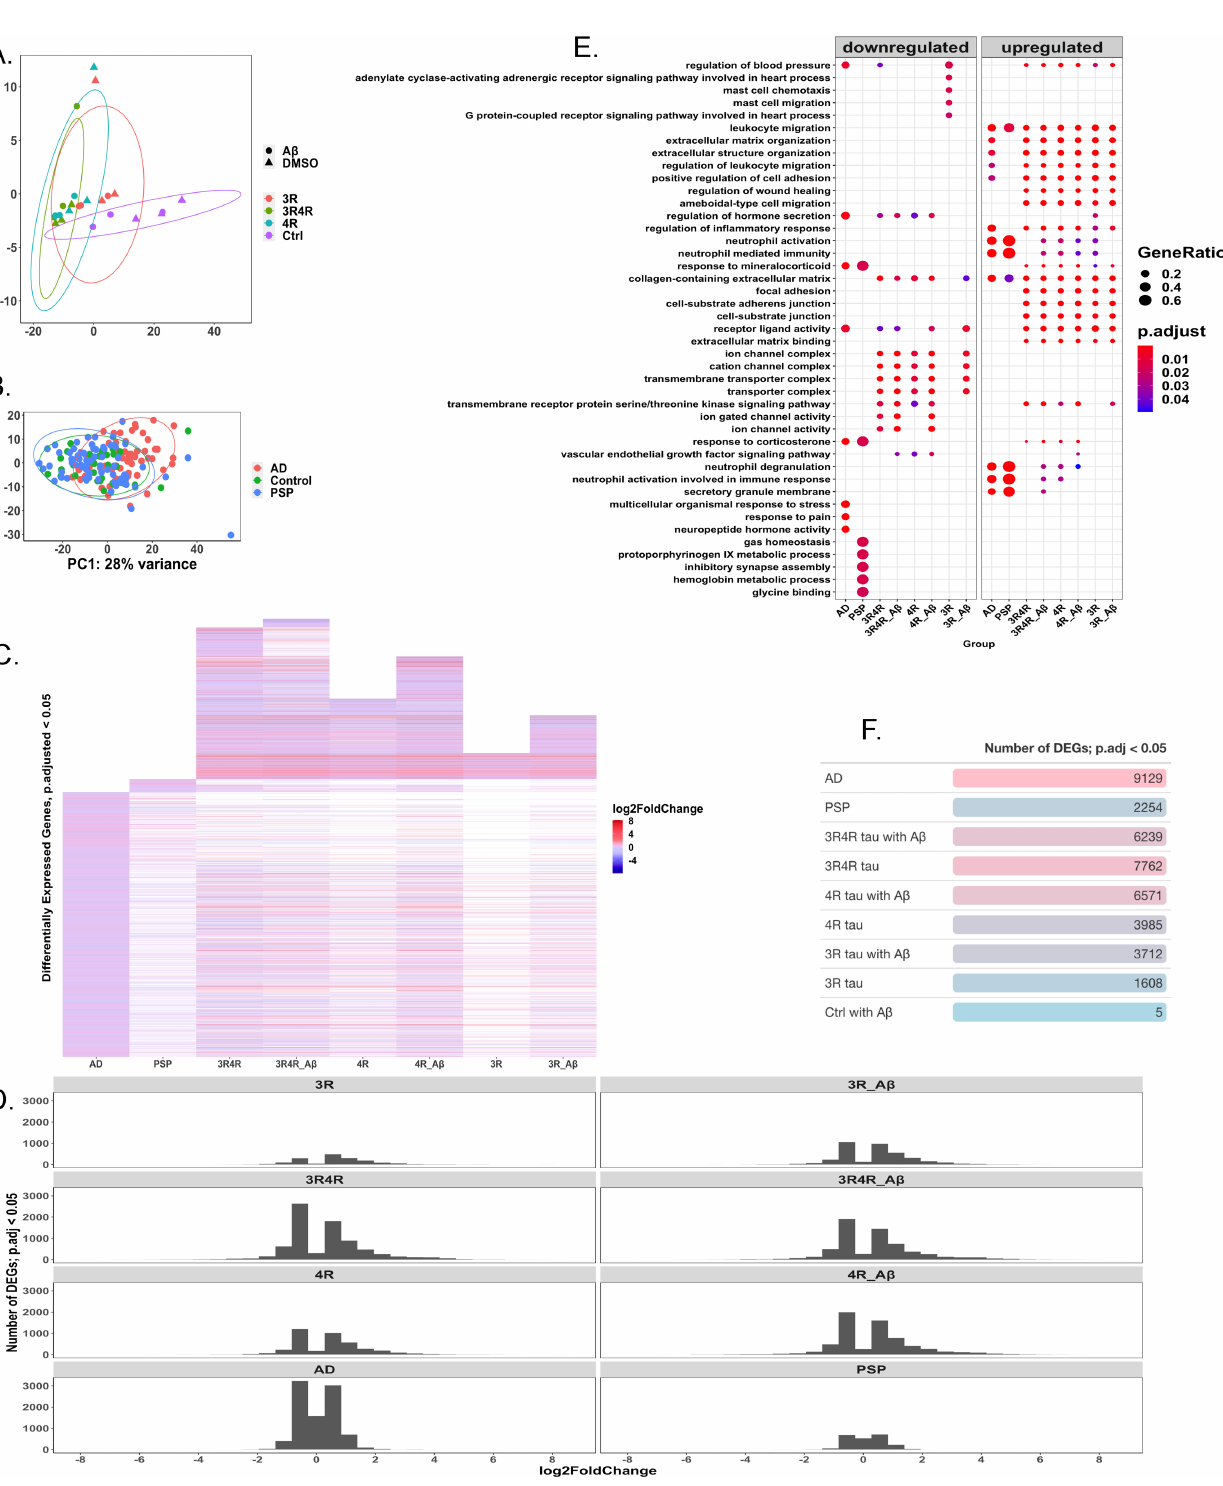
Fig 4. Patterns in differentially expressed genes in AD, PSP, and cell models. (A) PCA displaying grouping by gene expression between lentivirus and treatment conditions; PC1 accounts for 81% of variance between conditions and there is little separation between A β and DMSO-treated groups (N = 3). (B) PCA displaying grouping by gene expression between AD (N = 60), control (N = 33), and PSP (N = 71) patients. PC1 accounts for 28% of variation, with AD patients showing greater separation from control patients than PSP patients do. (C) Heatmap showing log-fold change in expression in genes considered significantly differentially expressed (FDR adjusted p-value < 0.05) in each measured group (AD, N = 60; PSP, N = 71; cell groups, N = 3 each) relative to their